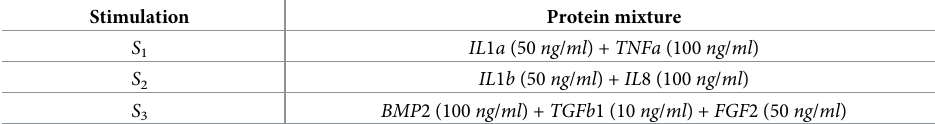
Table 2. Protein mixtures used as stimulations in the pharmacological case study.